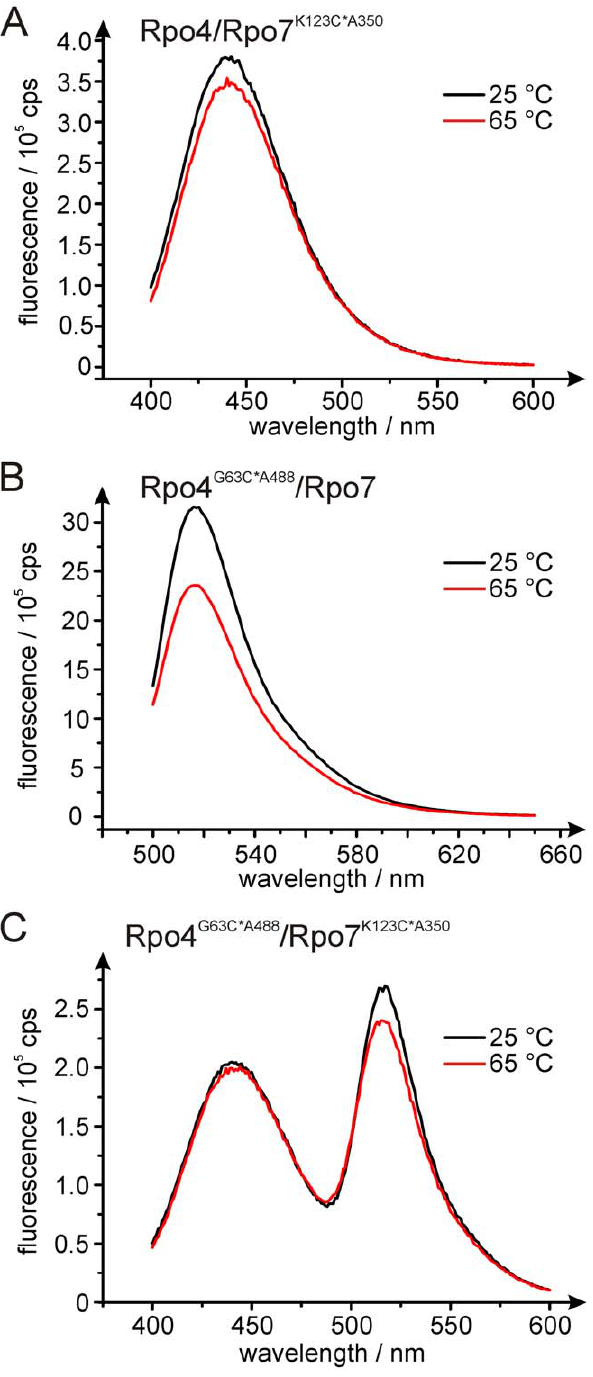
Figure 2. Influence of temperature on the emission intensity of fluorophores. Fluorescence emission spectra at 25 u C (black line) or 65 u C (red line) are shown for Rpo4/7 samples (50 nM) labeled with (A) donor only (Rpo4/Rpo7 K123C*A350 , excitation at 320 nm), (B) acceptor only (Rpo4 G63C*A488 /Rpo7, excitation at 493 nm) or (C) donor and acceptor (Rpo4 G63C*A488 /Rpo7 K123C*A350 , excitation at 320